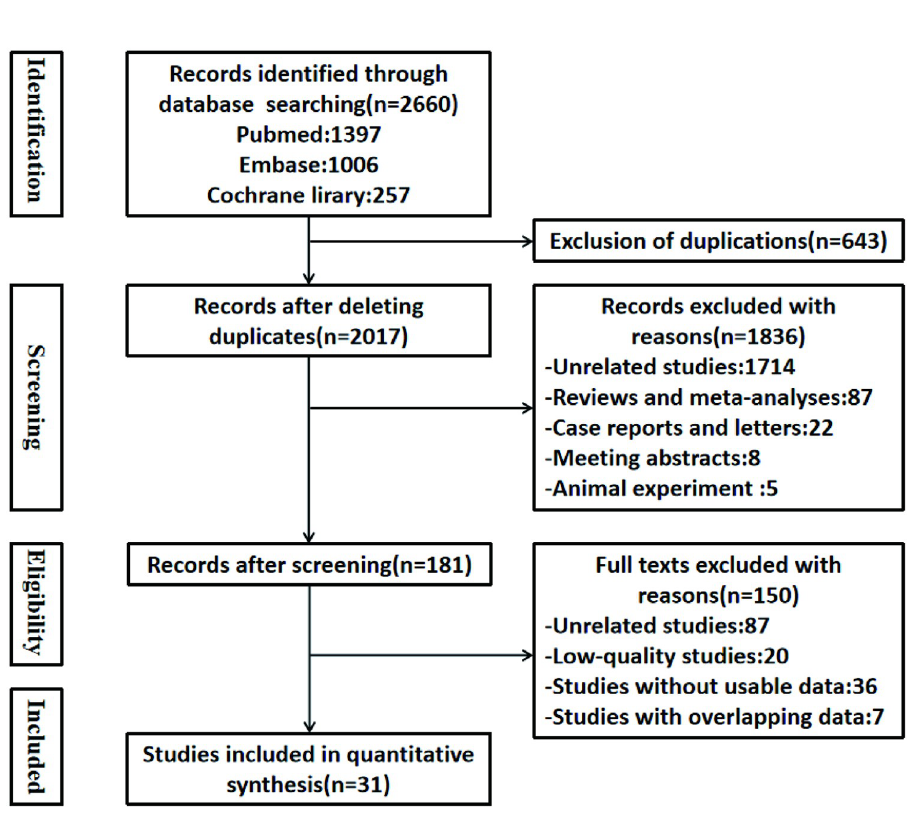
Fig 1. Flow chart of literature search and data